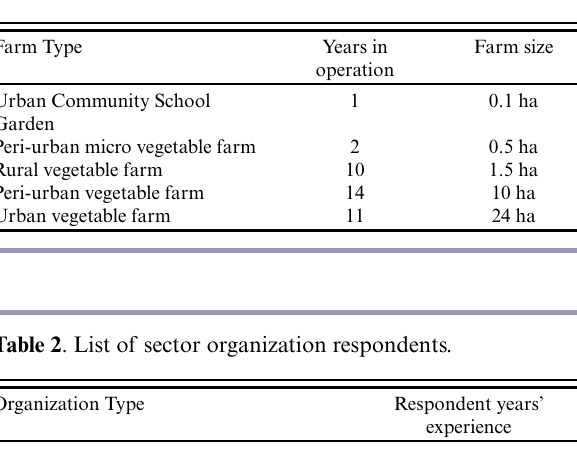
Table 1 . List of farmer respondents.